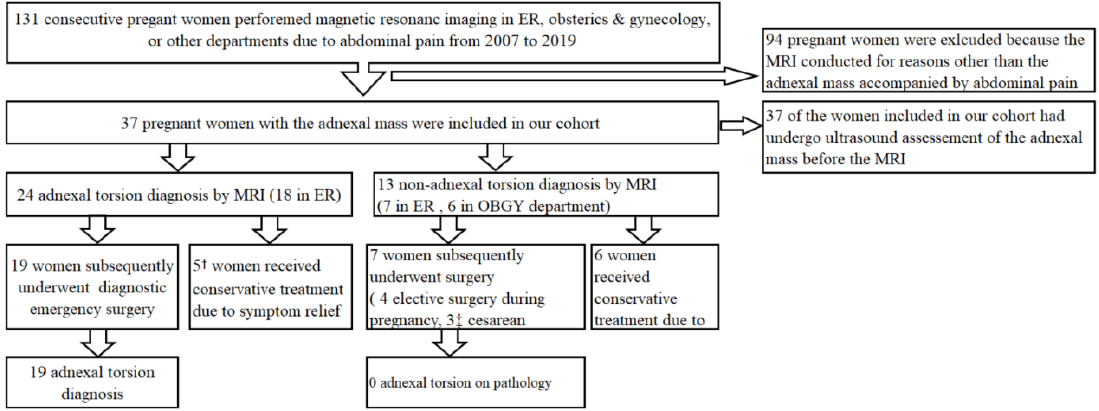
Figure 1. Flow diagram of the study participants. † One woman underwent ultrasound-guided aspiration of an ovarian cyst at 30.5 weeks’ gestation; two women did not undergo surgical extirpation of the mass, but the remaining two women (adnexal torsion MRI diagnosis at 5.2 and 9.5 weeks, respectively) confirmed no adnexal torsion during appendectomy with appendicitis (at 16.6 and 11.1 weeks, respectively) in pregnancy. ‡ A total of 3 women confirmed no adnexal torsion through simultaneous adnexal operation during cesarean section (1 emergent c / sec at 36.4 weeks, and 2 elective c / sec at 36.3 and 39.1 weeks, respectively). MRI, magnetic resonance imaging; ER, Emergent room; OBGY, obstetrics and gynecology.